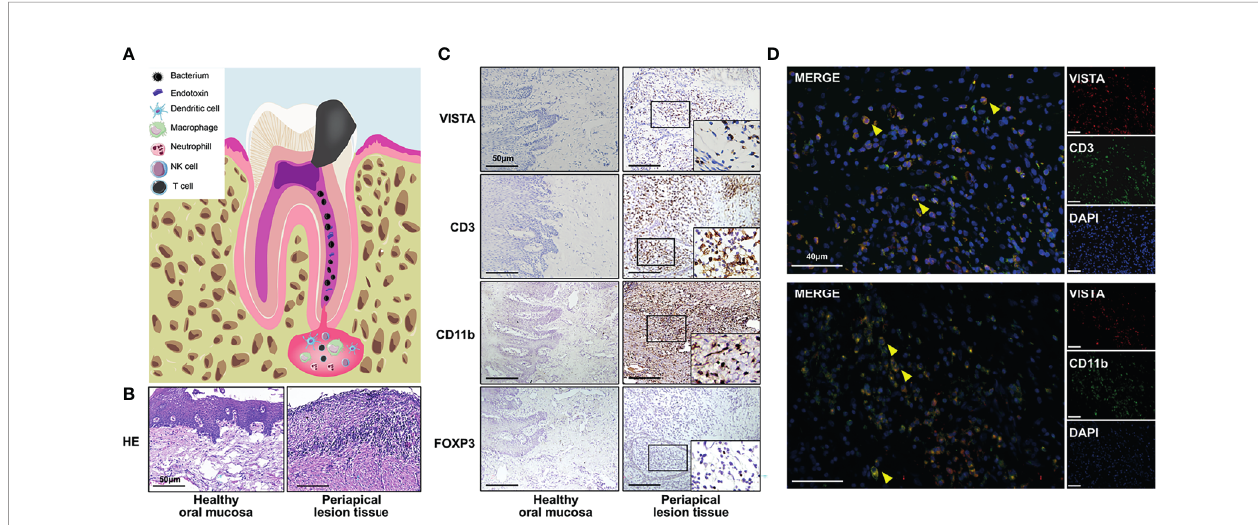
FIGURE 1 | The expression of VISTA and immune cell in fi ltration in in fl amed human periapical tissues. (A) Scheme of human apical periodontitis. (B) Hematoxylin- eosin staining of healthy human oral mucosa and periapical lesion tissue. (C) The accumulation of VISTA-, CD3-, CD11b-, and FOXP3-positive cells in healthy human oral mucosa (left panel) and periapical lesion tissue (right panel) (n=5). Scale bars=50 m m. (D) Colocalization staining of VISTA/CD3 and VISTA/CD11b in periapical lesions of human tissue. Scale bars=40 m